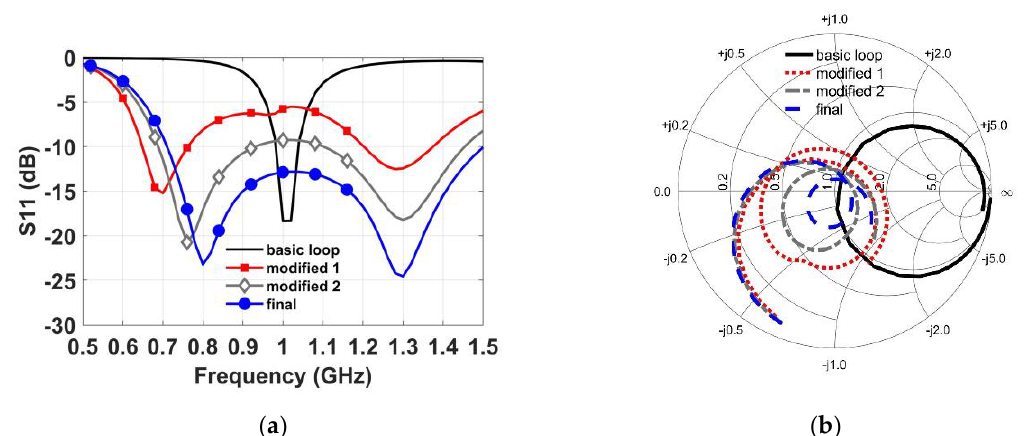
Figure 7. Antenna matching performance: ( a ) S 11 parameters. ( b ) Smith chart.